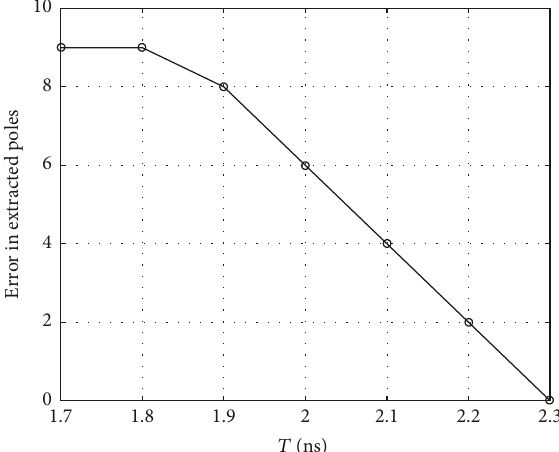
Figure 7: Using the proposed enhanced MP method: (a) pole- residue relationship and (b) frequency versus damping factor. Table 1: Parameters of the CPW